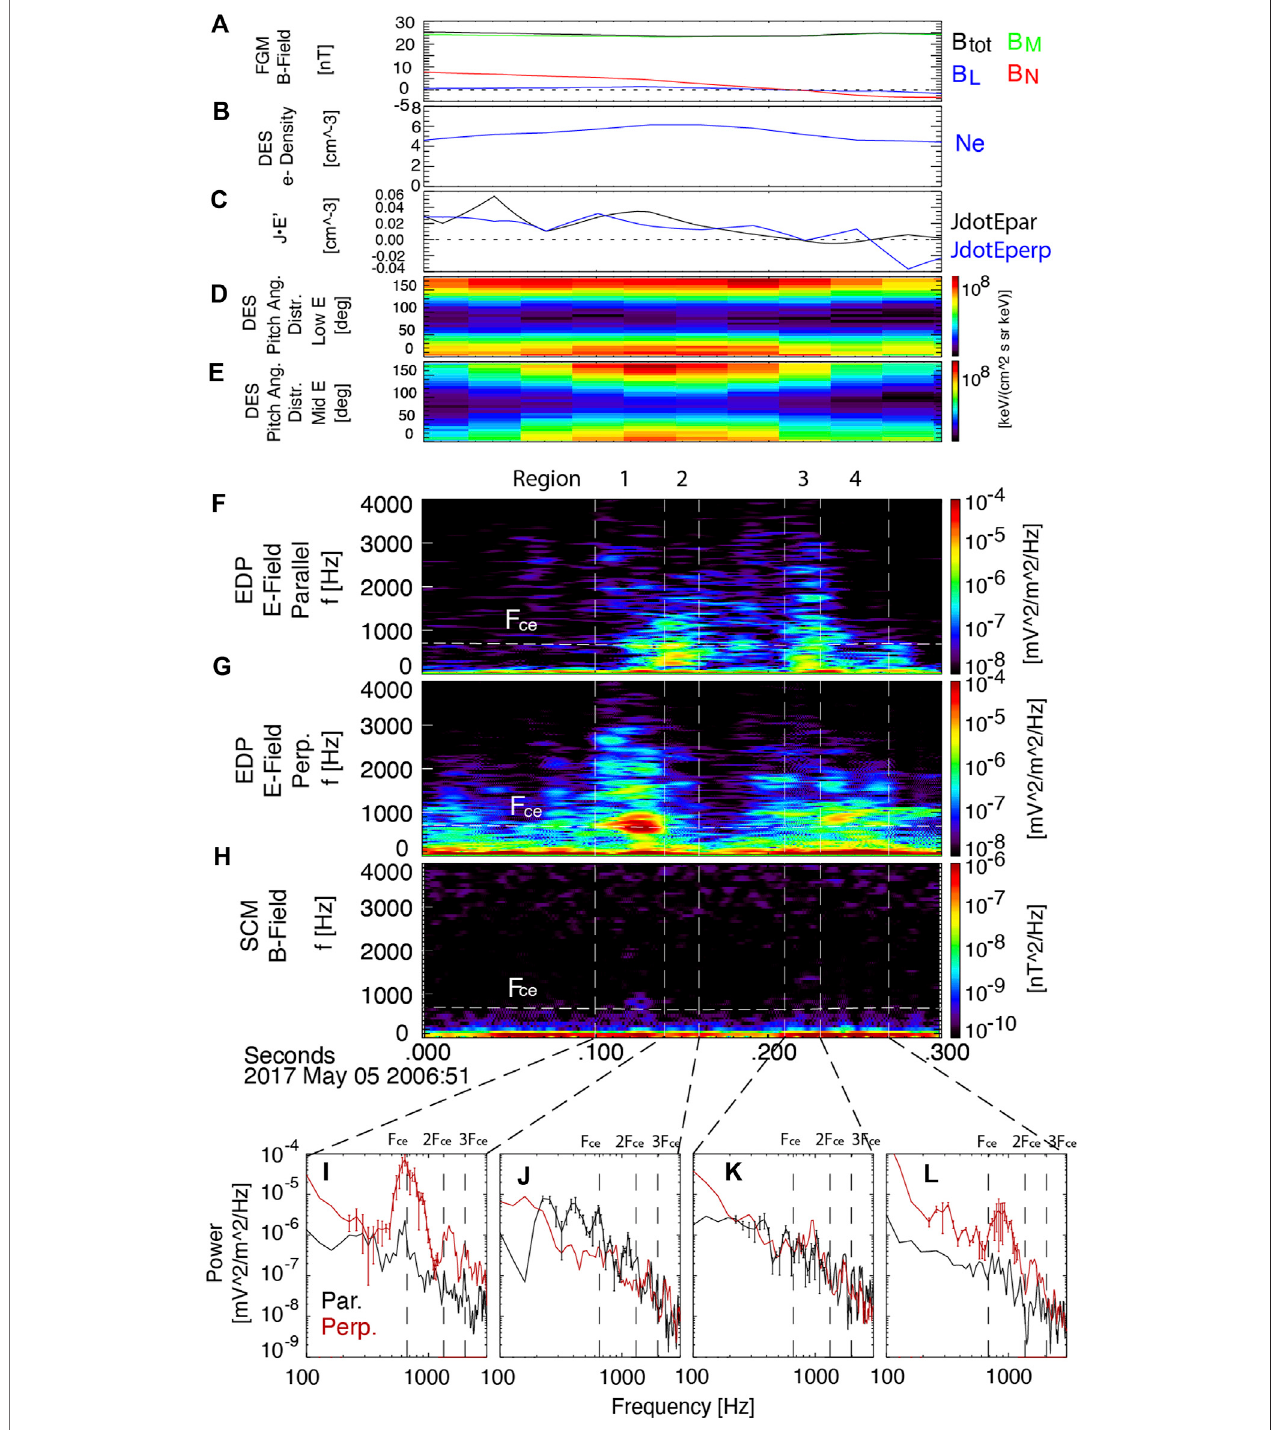
FIGURE 2 | Wave data near the depression of magnetic fi eld at the center of the fl ux rope. (A) Magnetic fi eld in LMN coordinate, (B) electron density, (C) energy dissipation proxy J · E ′ , (D) electron pitch angle distribution of low energy range, and (E) mid energy range, (F) power spectrum of the parallel electric fi eld, (G) perpendicular electric fi eld, and (H) magnetic fi eld. (I – L) Averaged power spectrum of electric fi eld in time ranges of (I) 20:06:51.100 – 0.140, (J) 0.140 – 0.160, (K) 0.210 – 0.230, and (L) 0.230 – 0.270 showing the distribution of parallel and perpendicular modes. (Error bars: standard errors).